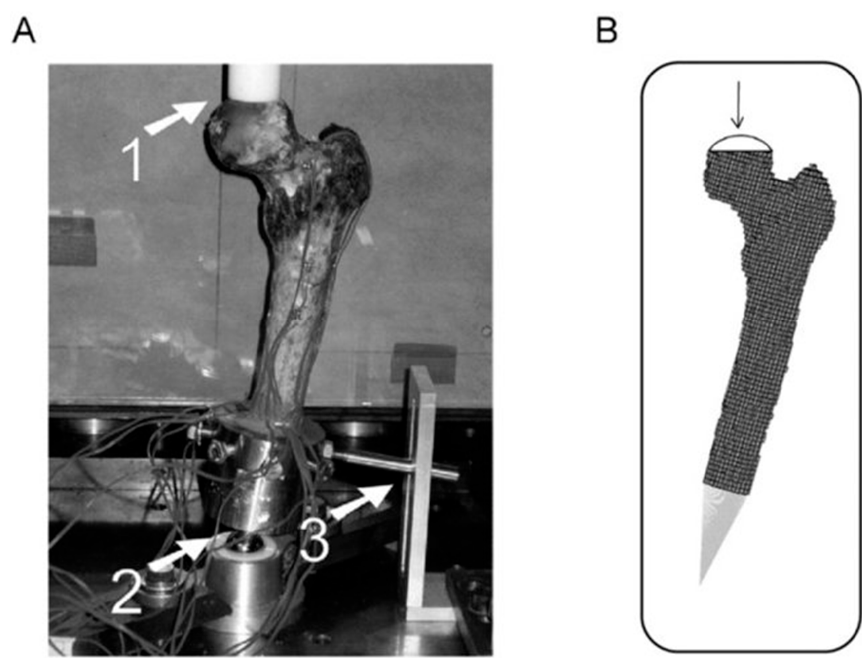
Figure 1. ( A ): Experimental setup and modeling using the CT-FEA method. (1) Plastic cup for applying the load; (2) point of rotation; (3) mechanism for locking the rotation. ( B ): Representation of the finite element model (From Tanck et al. [75], and Oftadeh et al. [70], CC-BY-SA 4.0).